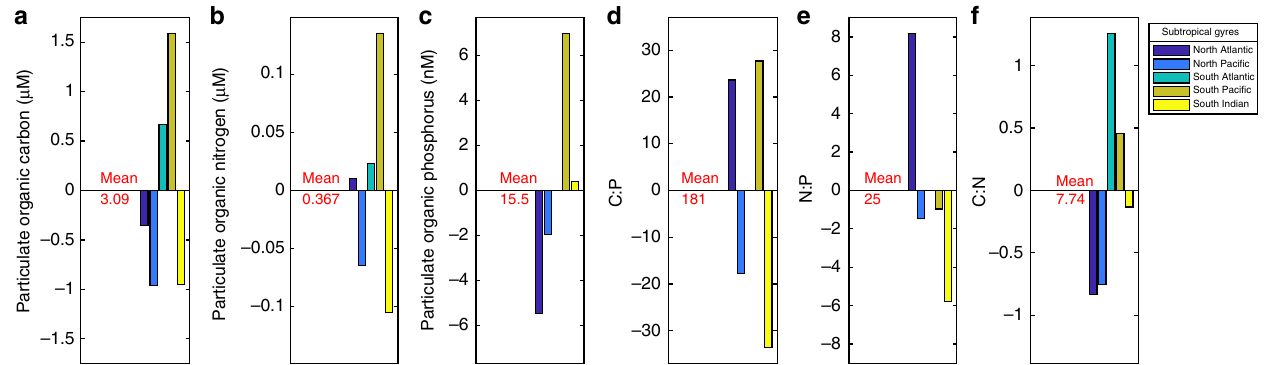
Fig. 6 Gyre anomalies for particulate organic matter concentration and ratios. Anomalies are relative to gyre mean (red text) for a particulate organic carbon (POC), b particulate organic nitrogen (PON), c particulate organic phosphorus (POP), d POC:POP (C:P), e PON:POP (N:P), and f POC:PON